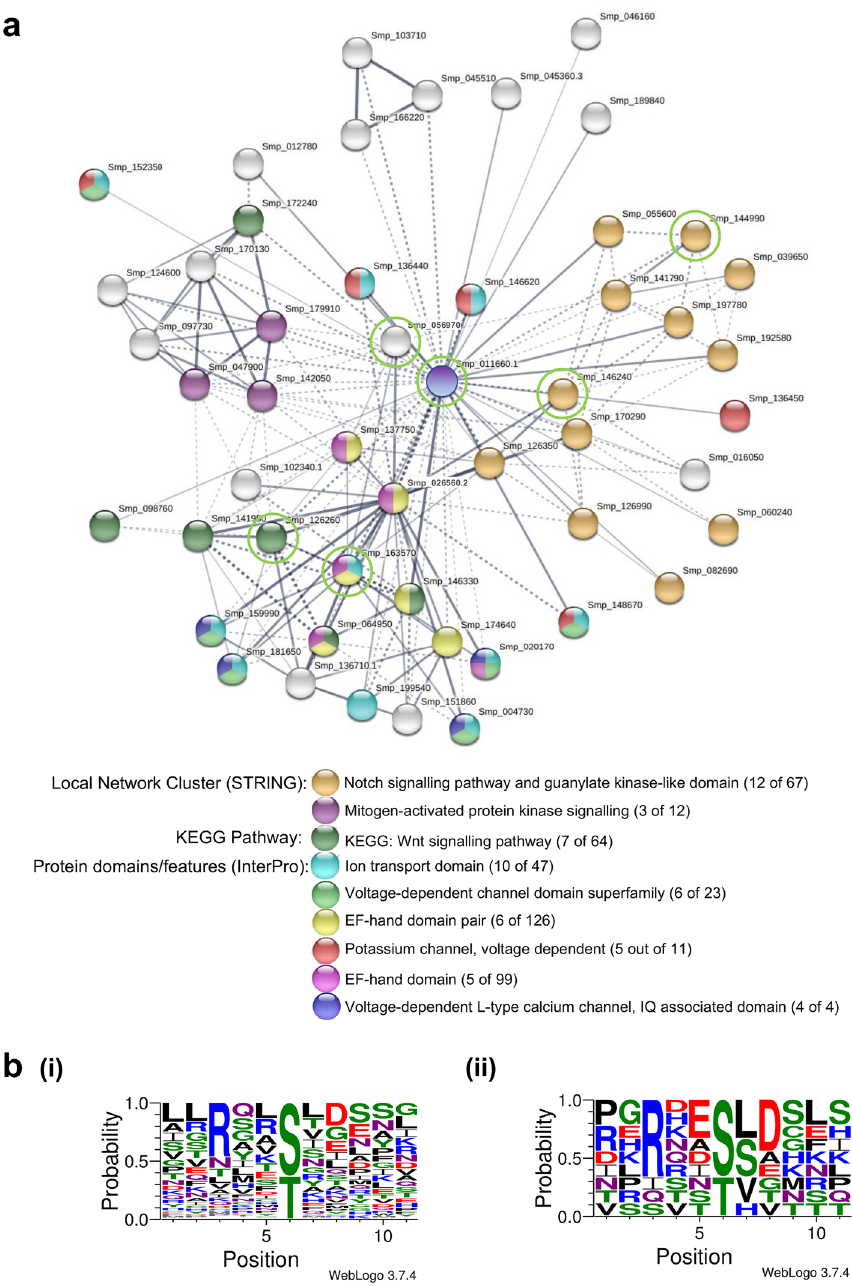
Figure 6. Network analysis of Schistosoma mansoni CaMKII associations. The CaMKII sequence (Smp_011660) was queried against the STRING database to identify putative physical/functional protein– protein associations. ( a ) First shell association map of medium confidence (STRING global score ≥ 0.40; protein–protein enrichment p < 1.0e −16 ) protein–protein (node) associations in confidence mode (thicker lines = higher confidence); inter-cluster edges are shown with dashed lines. Smp_011660 appears in the centre of the network. Functional enrichments were evaluated (Supplementary Table 1) and selected examples (see key) comprising local node clusters, KEGG pathways, and protein domain/features visualised and overlain in different node colours. The number of nodes shown for each enrichment is against the background of the entire S. mansoni genome as currently annotated within STRING. ( b ) Motif analyses generated with WebLogo 3 (probability mode) to illustrate (i) the nature of the putative CaMKII phosphorylation sites found in the association partners using NetworKIN, and (ii) those sites confirmed as being present in our phosphoproteomic dataset 21 , with ( a ) network proteins (nodes) highlighted for the latter with a green